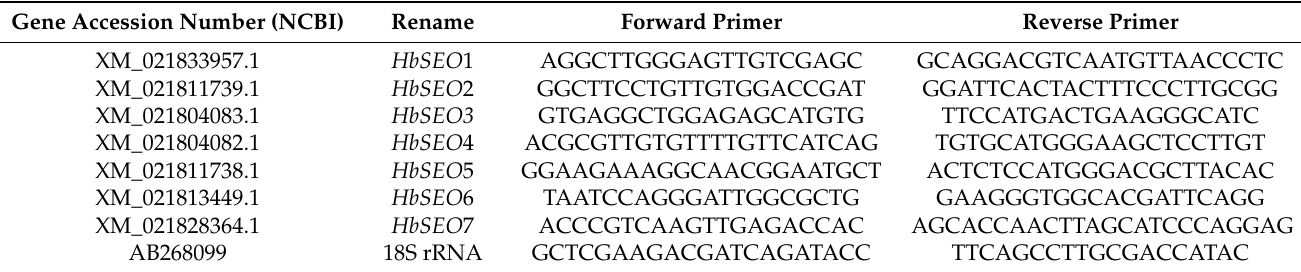
Table 1. qRT-PCR primers for expression analysis of HbSEOs .